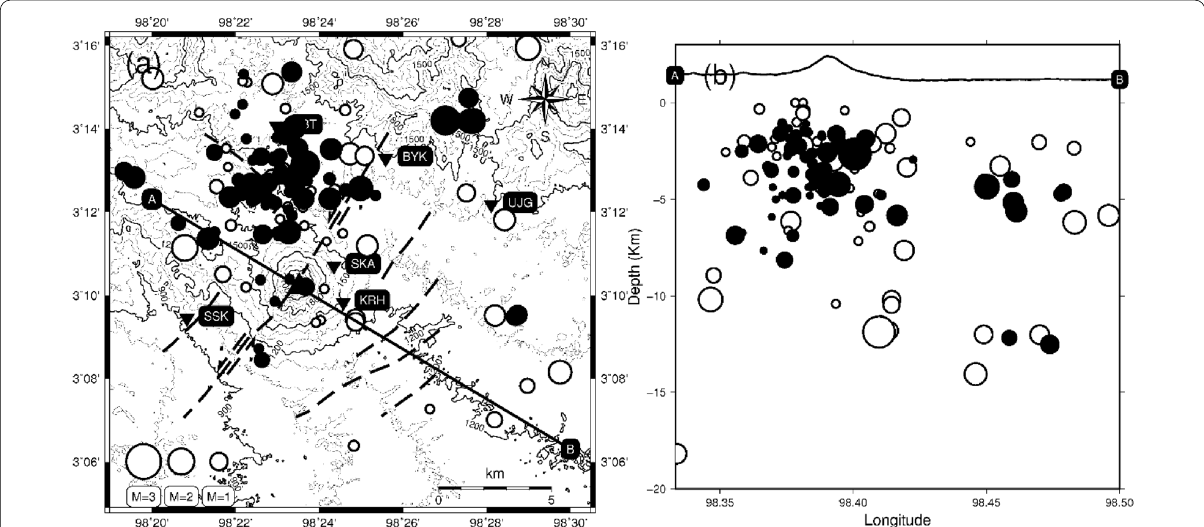
Fig. 2 a Seventy-eight relocated VTs (black dots) and b the depth cross-section along the line AB using the GAD catalogue for the initial locations (Afnimar et al., 2020). Thirty-one un-relocated hypocentres are plotted as open circles. The dot size is graded based on the magnitude values. The other legends are the same as in Fig. 1b